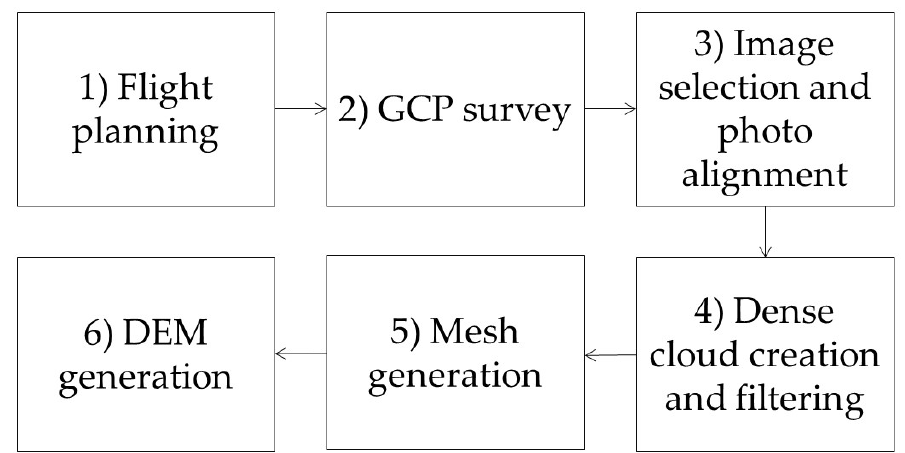
Figure 2. Flow chart of the Drone-DEM processing and production procedure. GCP, Ground Control Point.